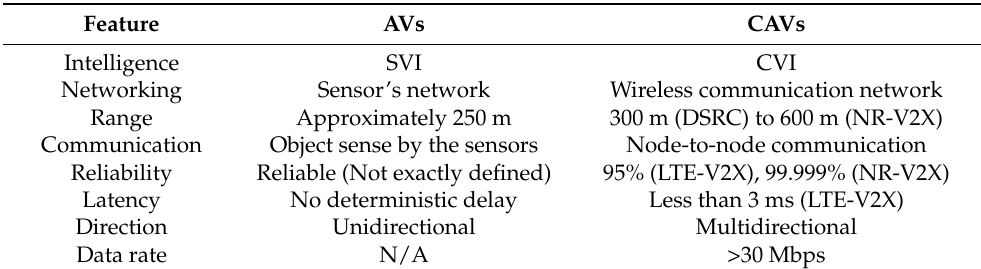
Table 1. The summarized features of AVs and CAVs.